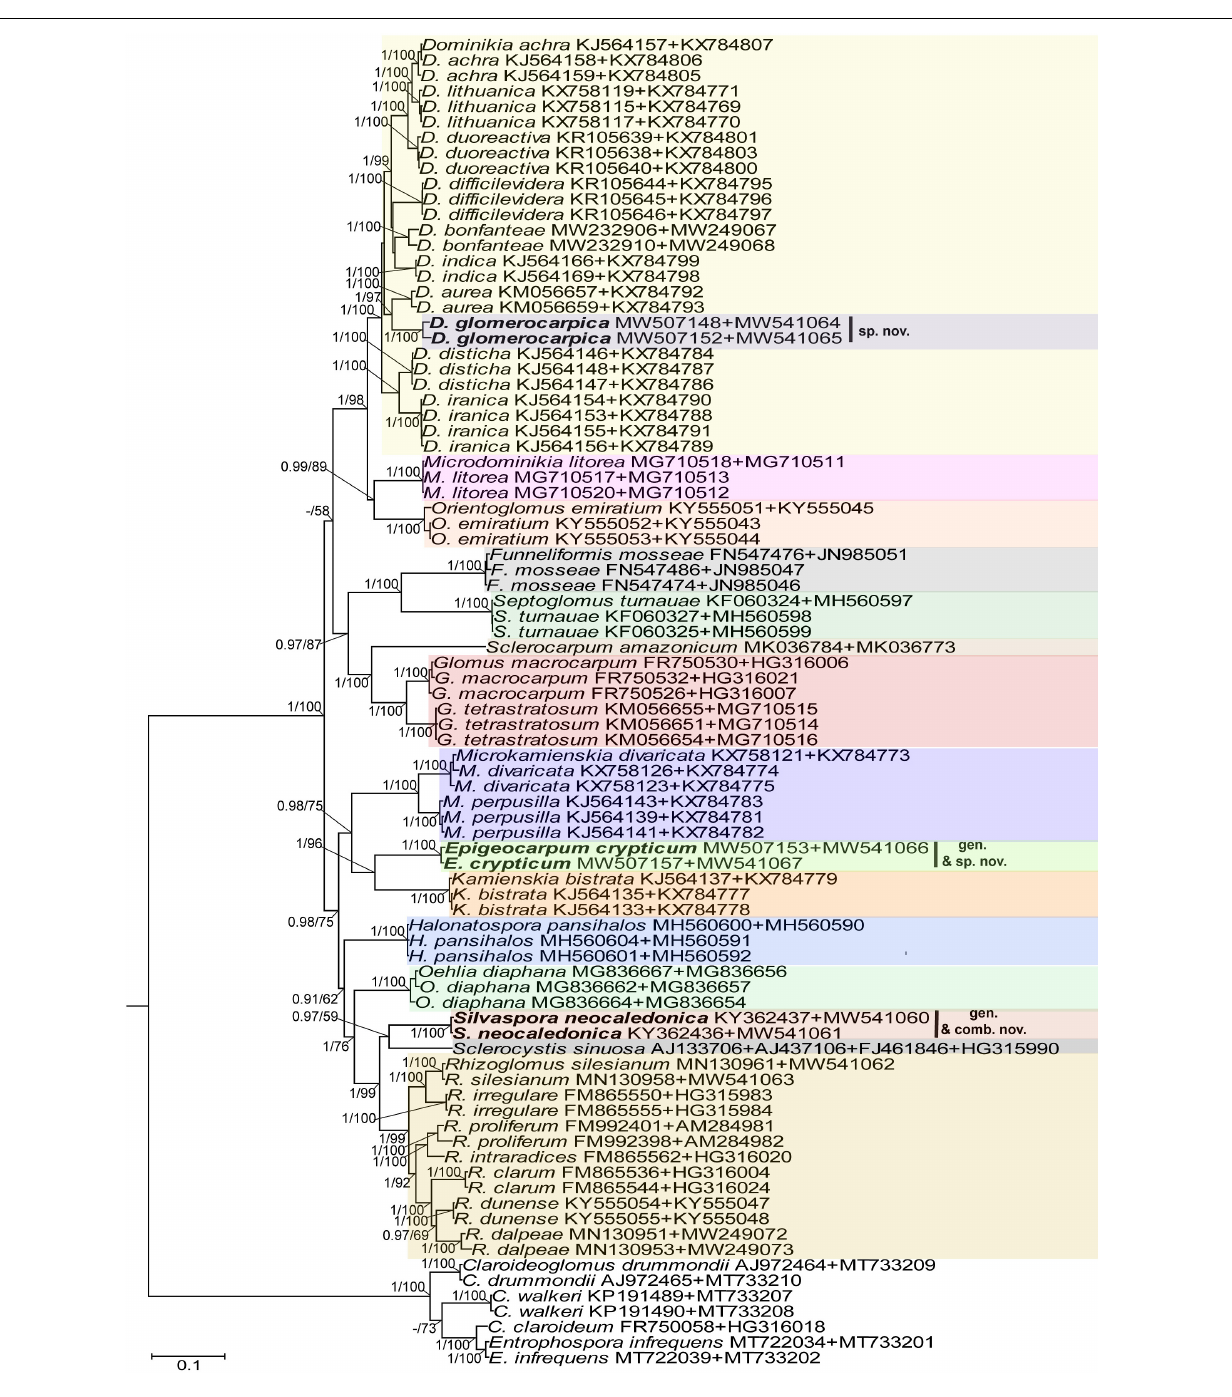
FIGURE 3 | A 50% majority rule consensus phylogram inferred from a Bayesian inference analysis of 18S-ITS-28S + rpb1 sequences of D. glomerocarpica and E. crypticum , as well as 34 other species of AMF, including C. claroideum , C. drummondii , C. walkerii , and E. infrequens as outgroup. The Bayesian posterior probabilities ≥ 0.90 and ML bootstrap values ≥ 50% are shown near the branches, respectively. Bar indicates 0.1 expected change per site per